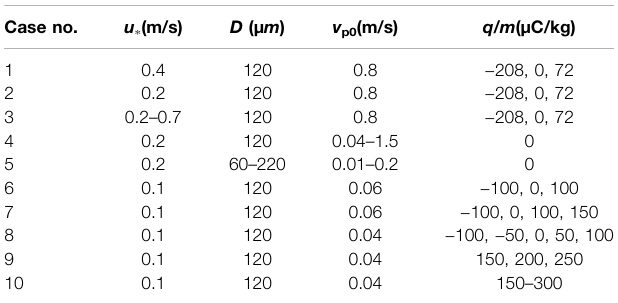
FIGURE 3 | The saltation trajectory of a single snow particle in the conditions of Nishimura and Hunt ’ s experiment (subgraph) (Nishimura and Hunt,